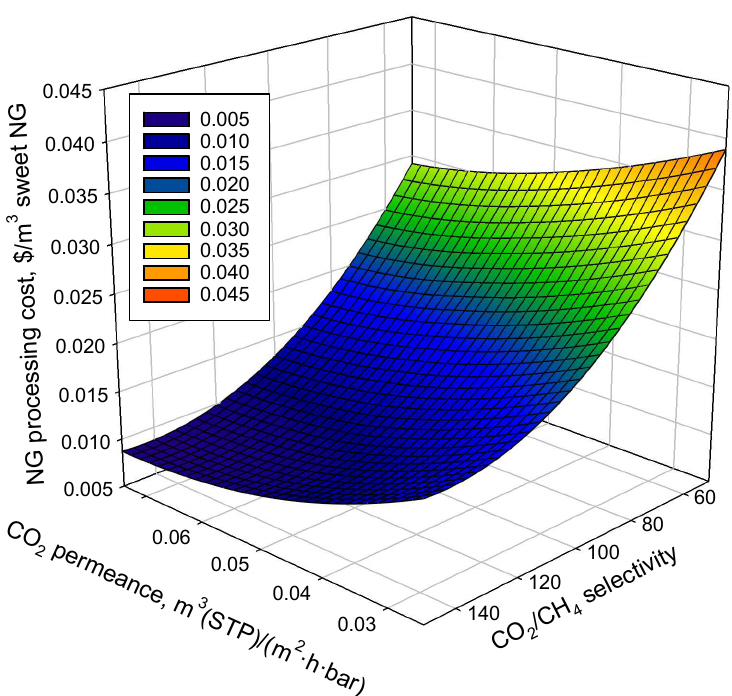
Figure 5. The influence of membrane separation performance on NG processing cost.